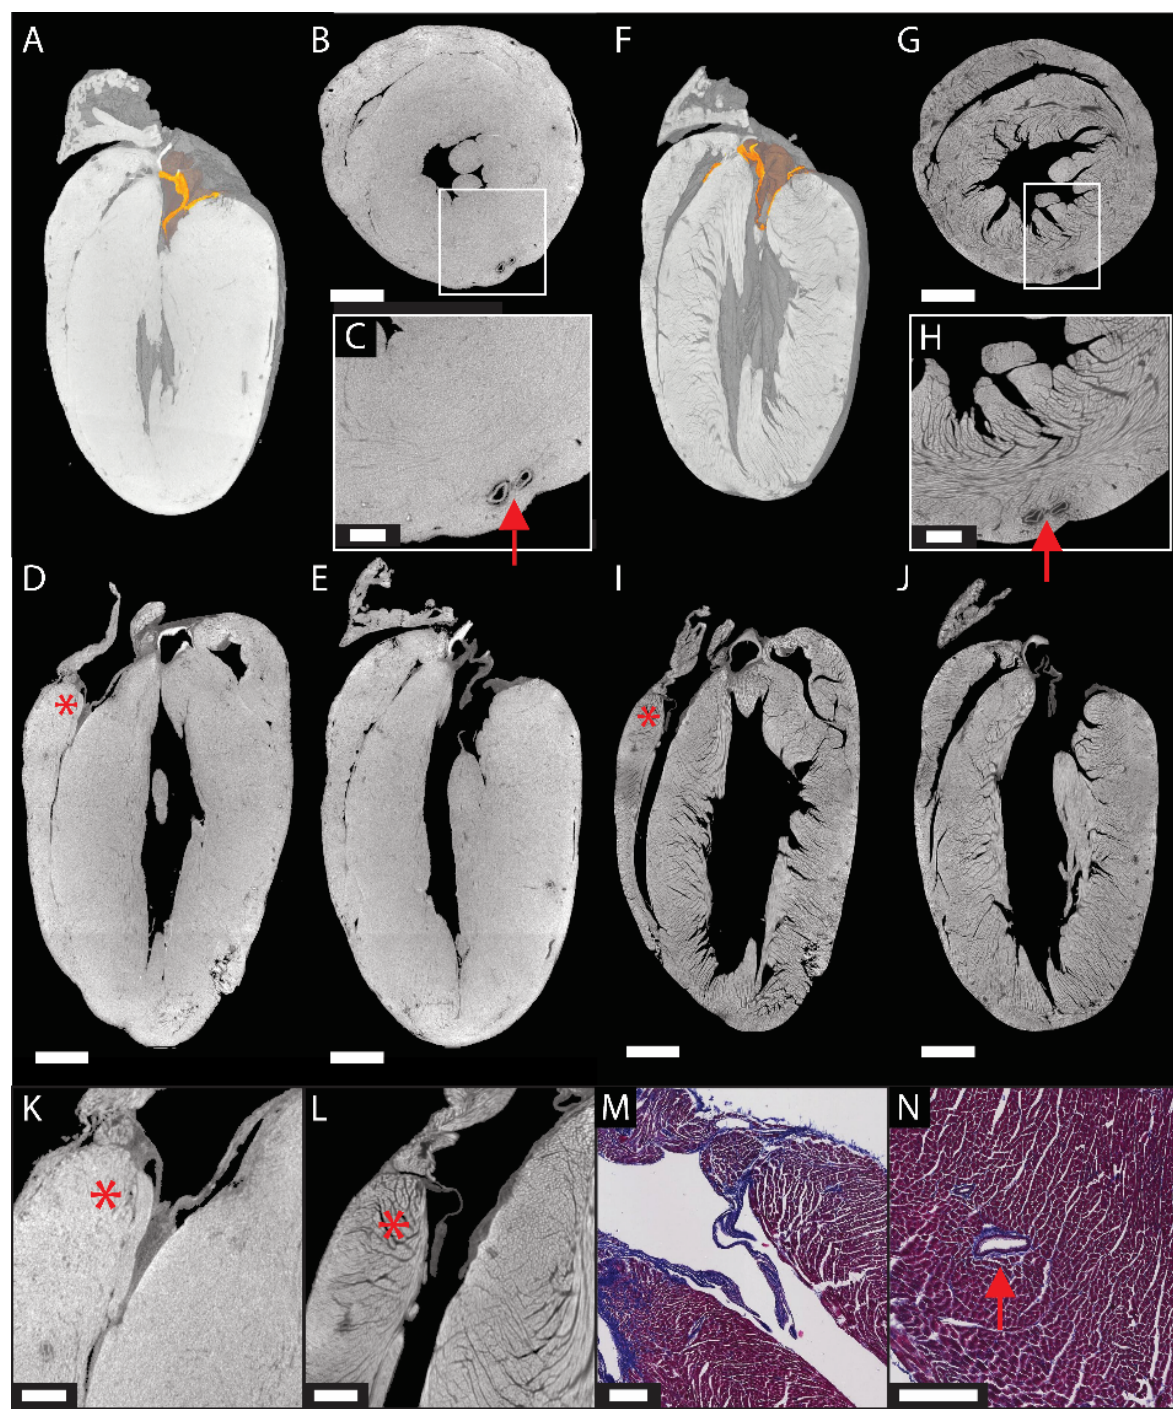
Figure 2. Whole-heart CE-CT imaging (Appendix A). Mouse heart stained with 3.5% ( wt/v ) Hafnium-substituted Wells-Dawson polyoxometalate (Hf-WD POM) ( A – D , K ), rinsed in phosphate-buffered saline (PBS) and then stained with 3.5% isotonic Lugol’s iodine ( E – H , J ). ( A , F ) 3D renderings with the heart valves in orange and ( B – E , G – J ) orthogonal slices. ( K , L ) A zoom-in on the tricuspid valve after Hf-WD POM and isotonic Lugol’s iodine staining, respectively. Arrows indicate blood vessels, and asterisks indicate the tricuspid valve. Scale bars are 1 mm ( A , B , D – G , I , J ), 0.3 mm ( C , H , K , L ) and 0.2 mm ( M , N